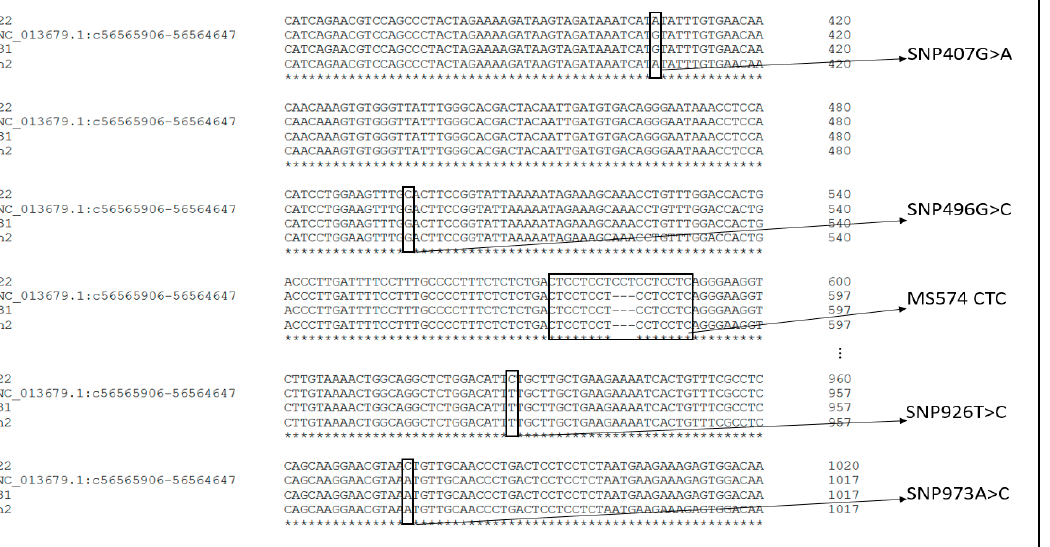
Figure 1. The four point mutations and the microsatellite in the promoter region of PRLR sequence (NC_013679.1 is the reference sequence from the GenBank, the * indicates identical nucleotides in the